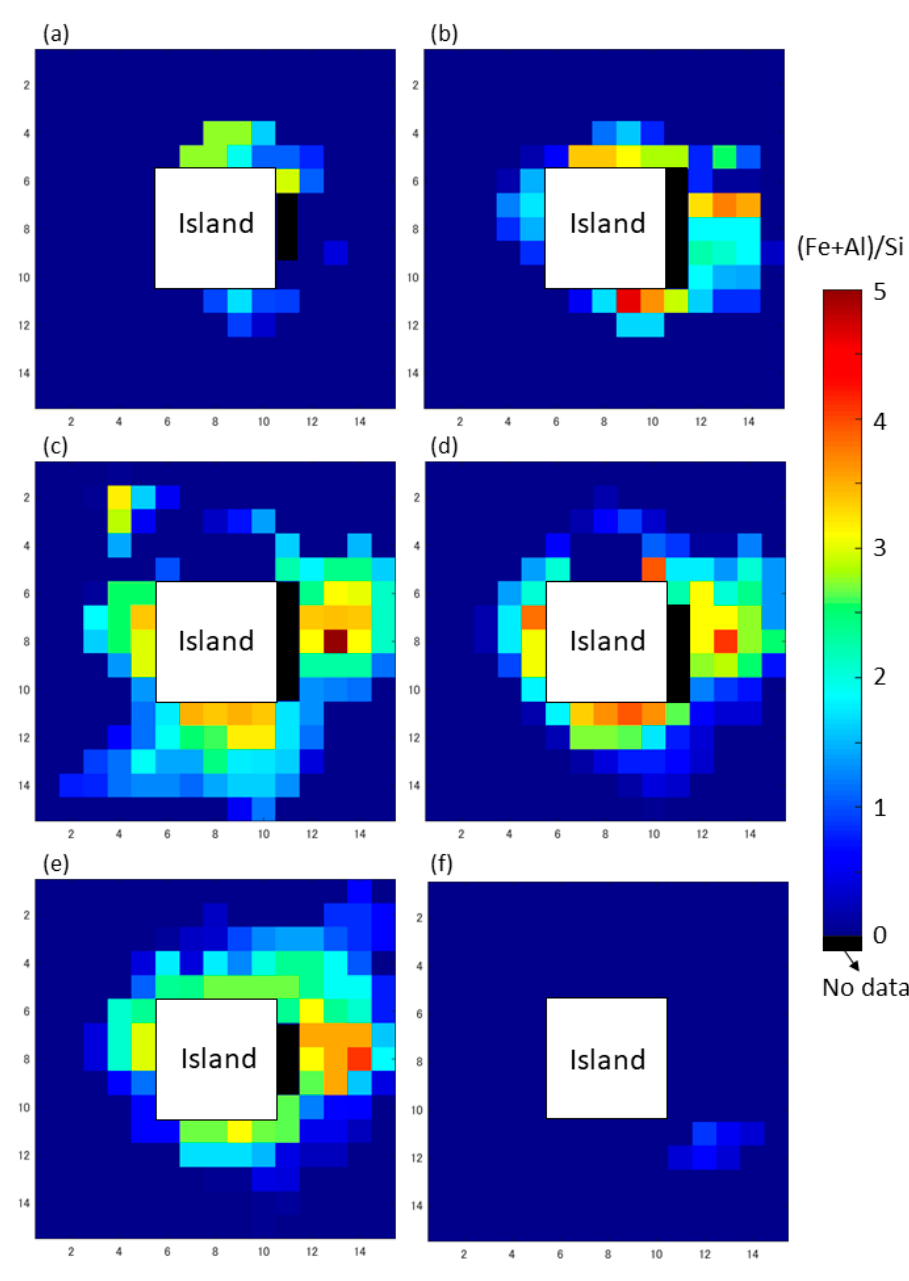
Figure 7. Example of the (Fe + Al)/Si distribution as a volcanic activity index from May 16 to June